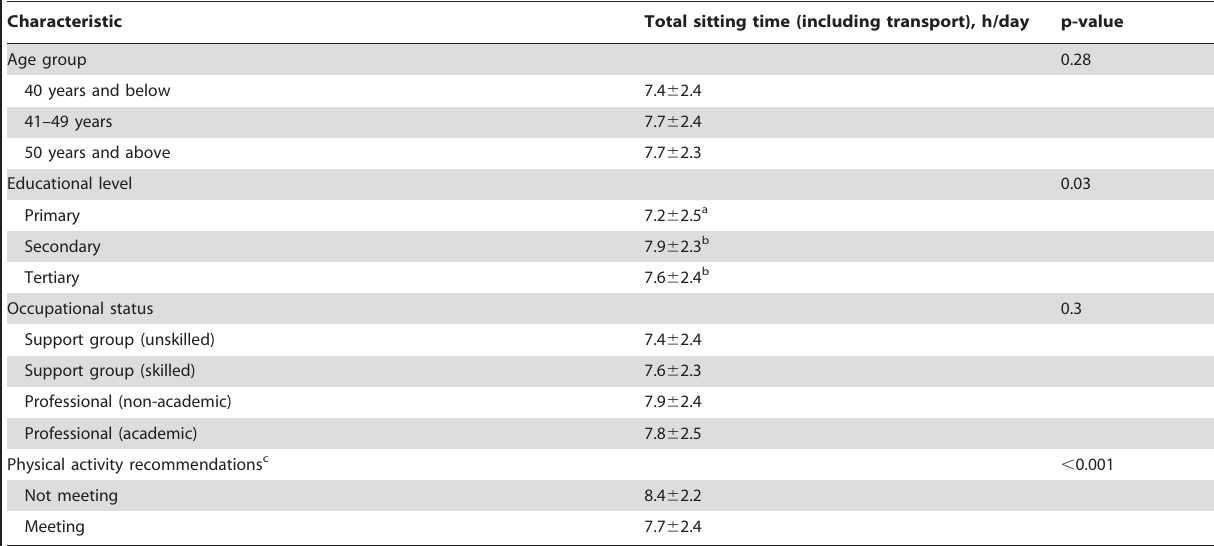
Table 2. Comparisons of sitting time and socio-demographic characteristics.